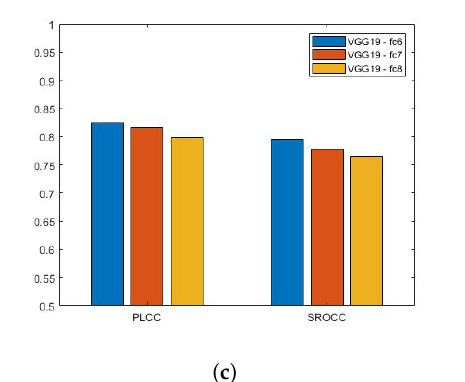
Figure 3. Performance comparison of deep features extracted from ( a ) AlexNet [20], ( b ) VGG16 [21], and ( c ) VGG19 [21]. Median Pearson’s linear correlation coefficient (PLCC) and Spearman’s rank order correlation coefficient (SROCC) values were measured over 100 random train–test splits. Table 3. On the ImageNet [35] database pretrained CNNs used in this study.